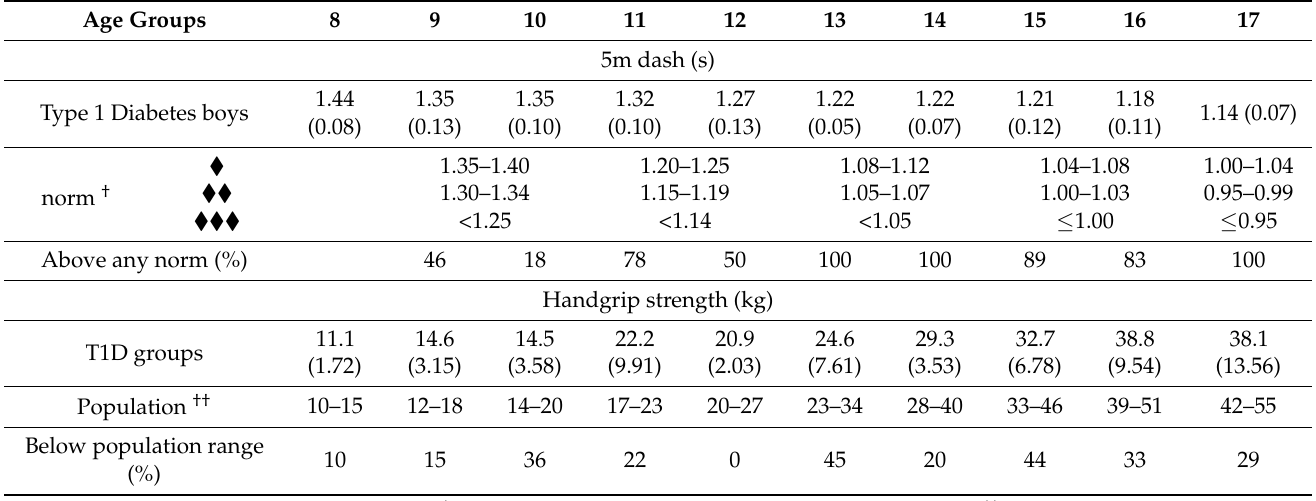
Table 3. Scores of Polish boys aged 8–17 years with type 1 diabetes for 5 m dash (s; M (SD)) and handgrip strength (kg; M (SD)) in comparison with the norms for the healthy